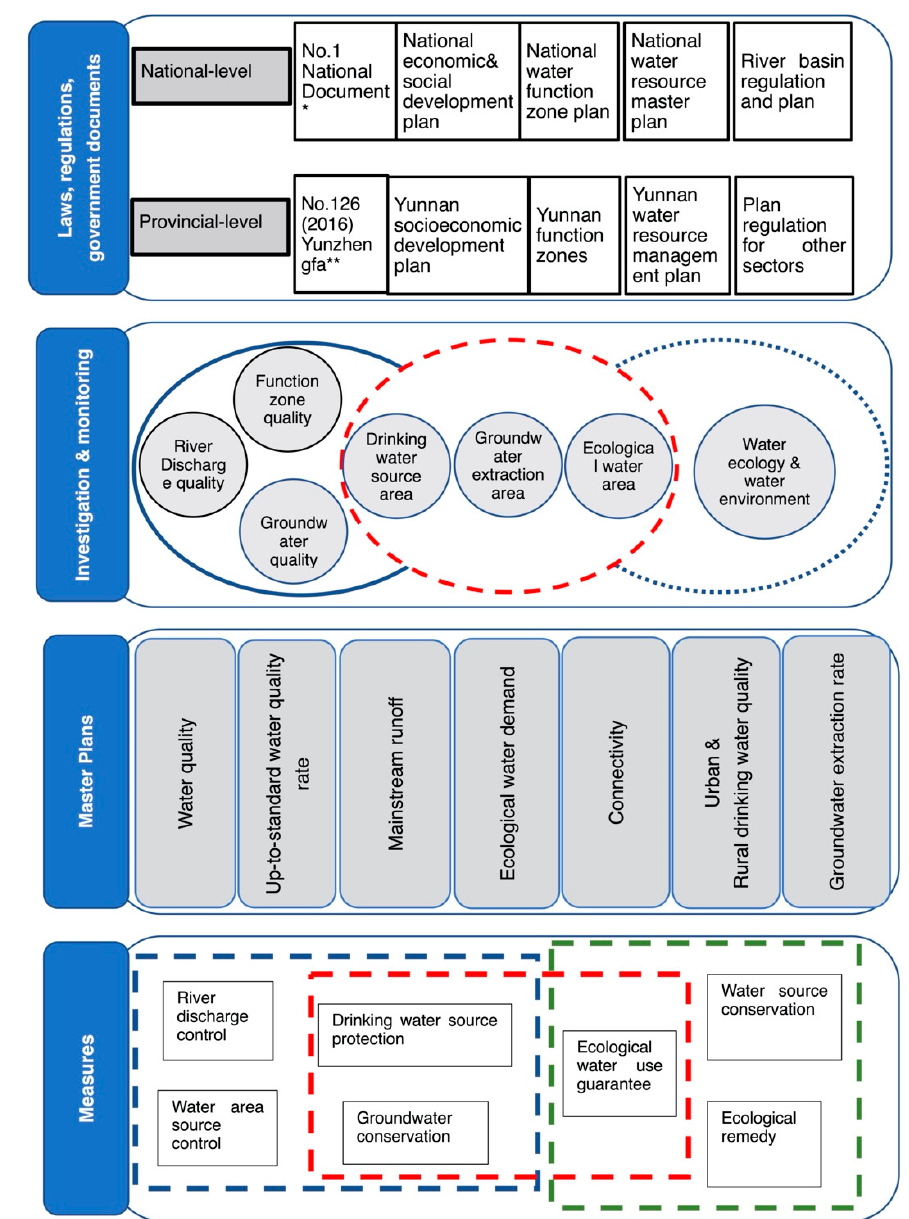
Figure 6. Lijiang water management system. ( *No.1 National Document is an annual policy document issued by the State Council of PRC (People Republic of China), focusing on rural development; *No.126(2016)Yunzhengfa is Yunnan provincial policy document on Five-year-plan, 2016 for instance is No. 126